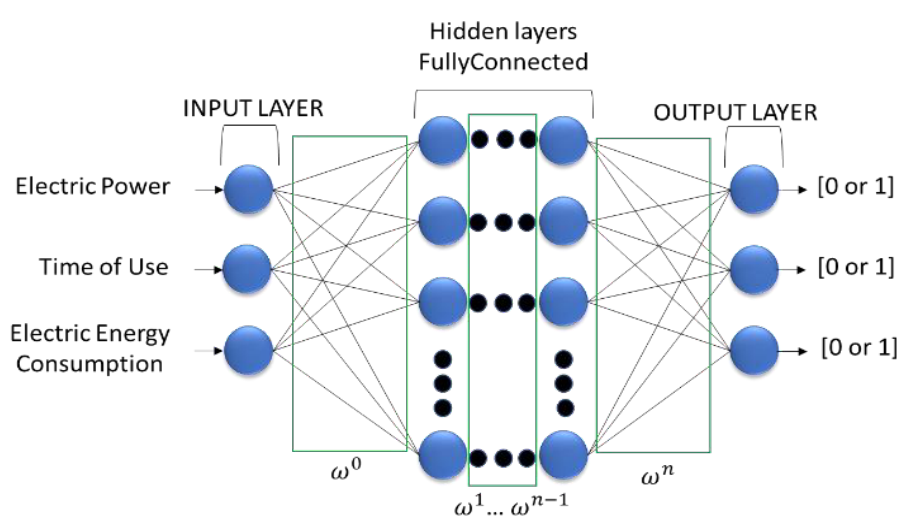
Figure 4. General architecture of the ANN. Where 𝜔 = weight and n= Layer number